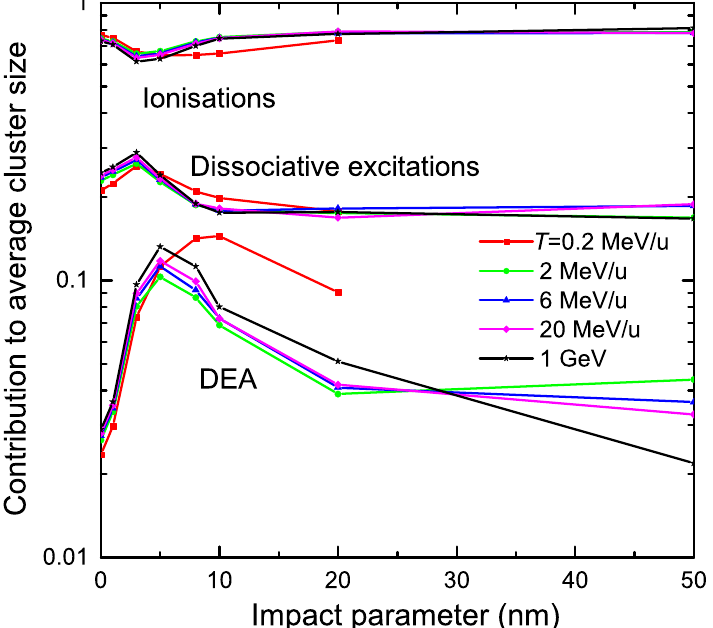
Figure 15. Fractional contribution of different physical mechanisms (ionisations, dissociative excita- tions, DEA) to the average cluster size in a cylinder with a dimension of two DNA turns for several carbon-ion kinetic energies and impact